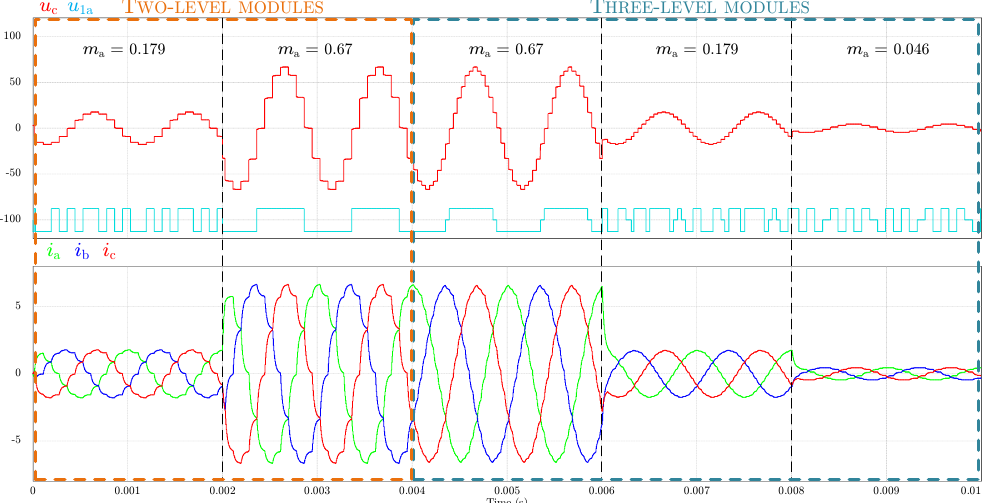
Figure 10. Example voltage and current waveforms of the 12-pulse modular VSI with two-level ( left ) and three-level ( right ) modules.